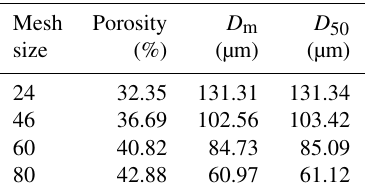
Table 3. Pore size characteristic values for four permeable stones with different particle sizes.